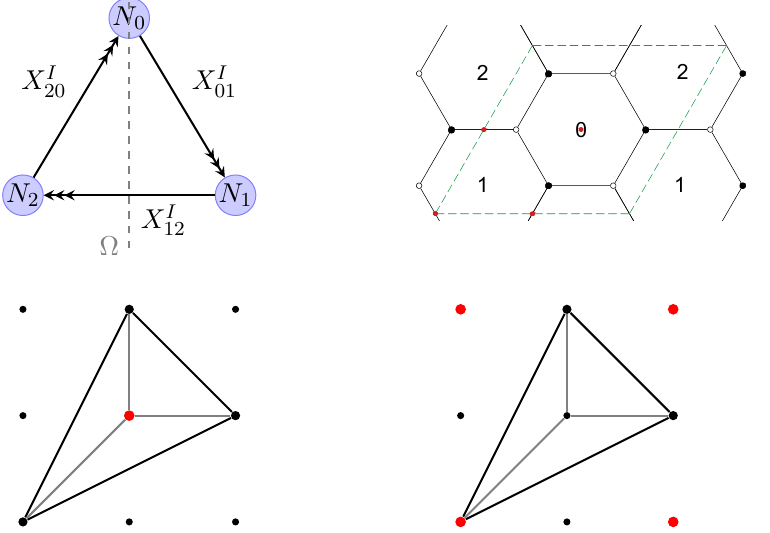
Figure 8. The various unoriented descriptions of C 3 = Z 3 . The upper row shows the quiver (left) and the (cid:10)-line, whereas on the right side the dimer, with the four (cid:12)xed points in red. In the lower row: the toric diagram and the toric involution with a compact (cid:10)7 (left) and a non-compact (cid:10)7